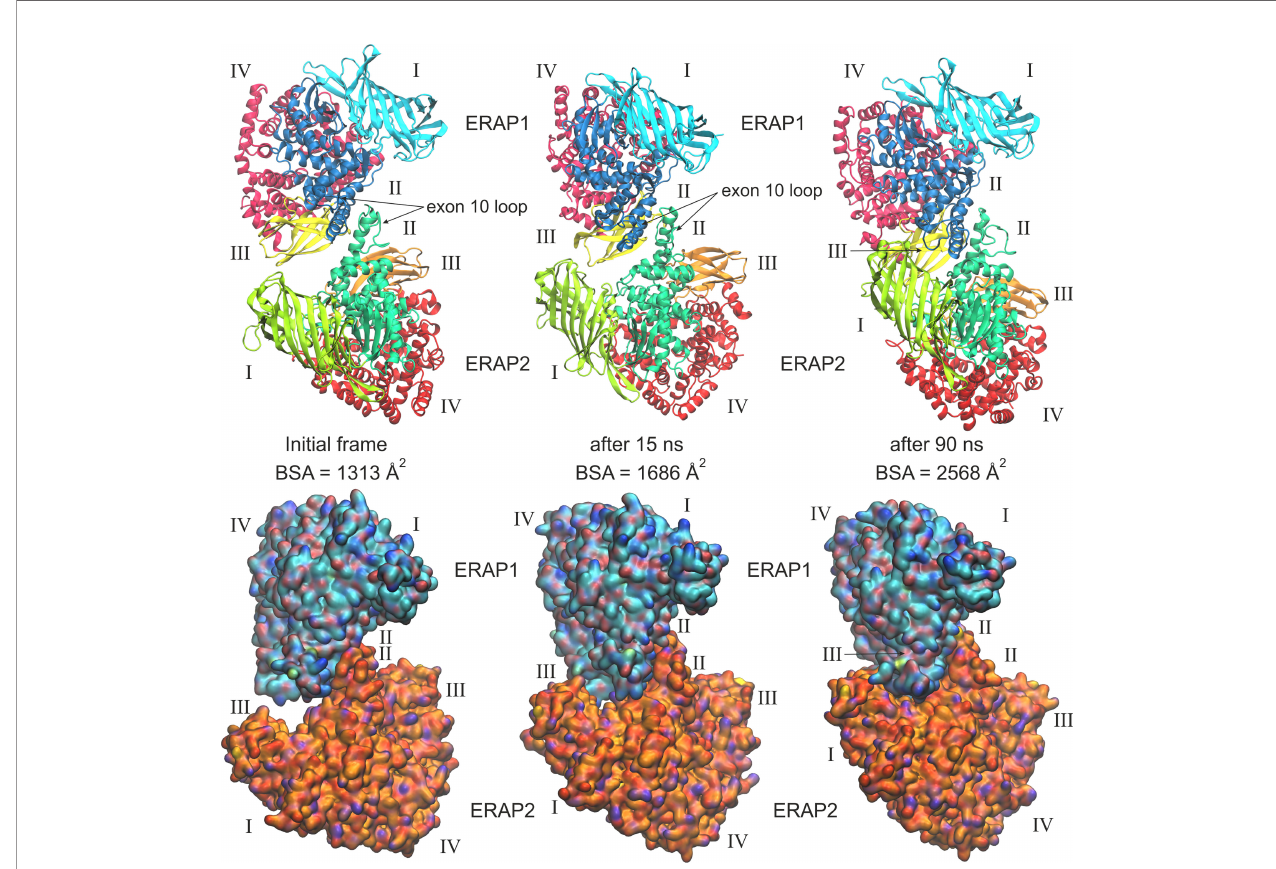
FIGURE 4 | Ribbon representations (upper panels) and surface representations (lower panels) of 3 frames from one MD simulation of the most favorable heterodimeric ERAP1/ERAP2 topology B2, illustrating the initial, energy minimized and two snapshots at 15 and 90 ns of the simulation. Domains are designated with Latin numbers and surfaces are colored with cyan C atoms for ERAP1 and orange C atoms for ERAP2. The position of the interacting exon 10 loop and the buried surface area (BSA) of each complex are